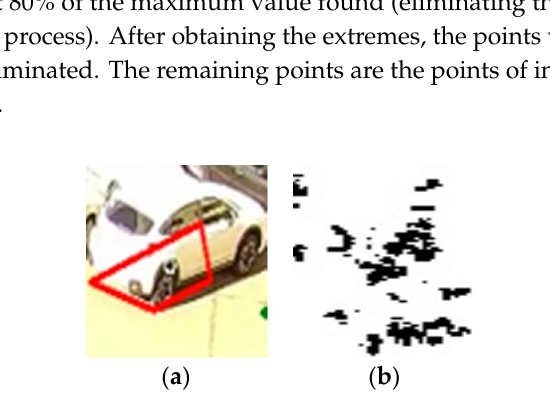
Figure 5. The image of ( a ) sunny parking space; ( b ) the result of SIFT corner detector.